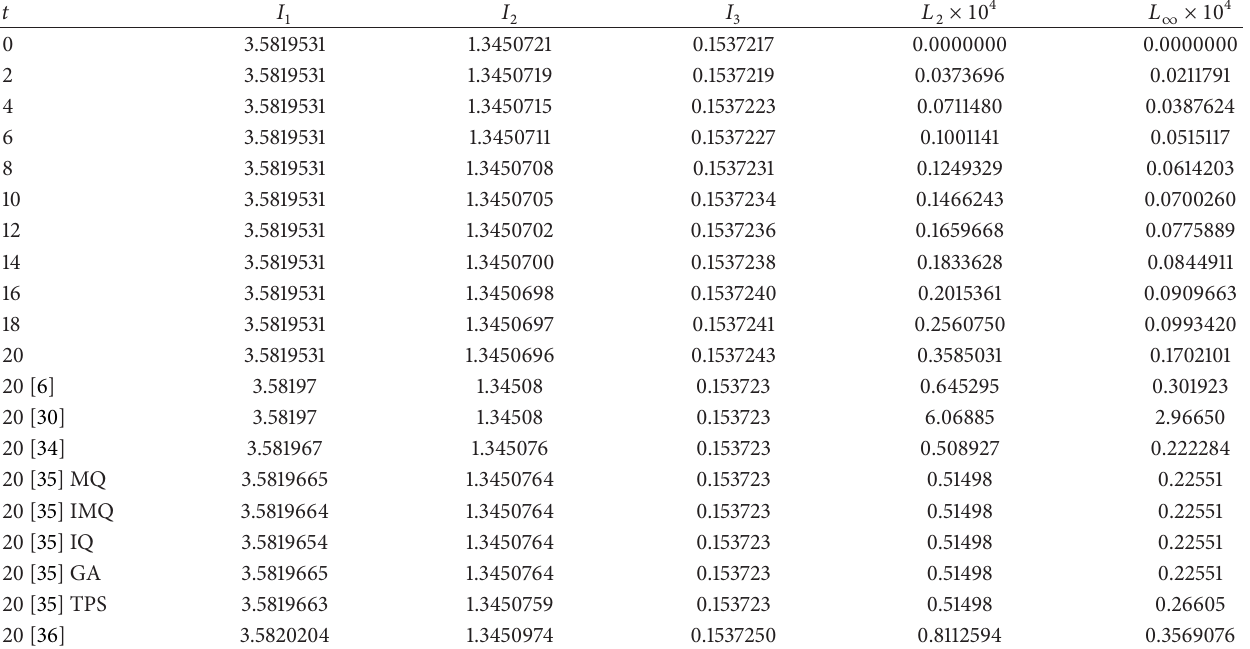
Table 3: Invariants and error norms for single solitary wave with 𝑐 = 0.3 , ℎ = 0.1 , 𝑘 = 0.01 , 0 ≤ 𝑥 ≤ 100